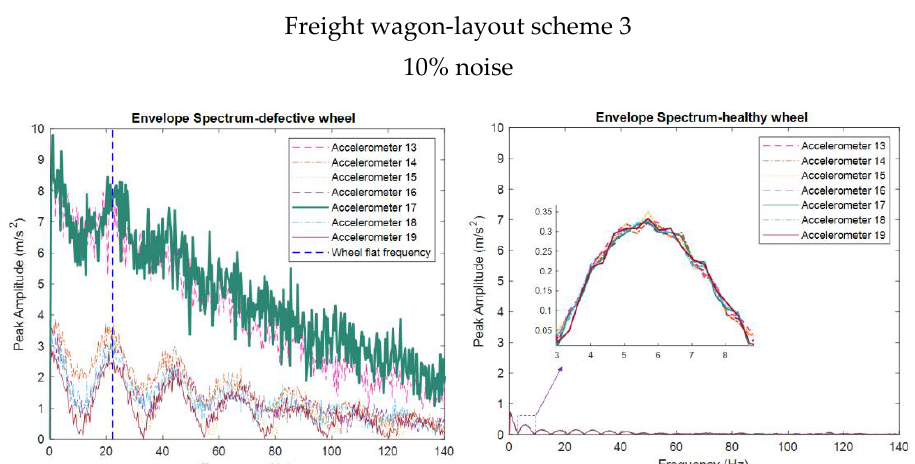
2 ) Figure 16. Optimization of the sensor layout. The installation along an equivalent wheel perimeter length (2 (cid:2024)(cid:1870) (cid:3050) = 2.7 m ) is useful for monitoring the entire perimeter of the wheel. Figure 16 shows that from an economic point of view, two accelerometers are needed to distinguish a defective from a healthy wheel. Regarding the position of the sensors, it is better to install them so that, with every rotation of the wheel, each sensor monitors half the length of the wheel perimeter. The length of the wheel perimeter is 2 (cid:2024)(cid:1870) (cid:3050) = 2.7 m . Therefore, each time the defective wheel contacts the surface of the rail, the same impact will occur again 2.7 m later. For example, if the flat impact location occurs before accelerometer 19 (see Figure 5), it means that in the previous rotation of the wheel, the accelerometer 14, which is located 3.0 m away, could also detect the impact at a close distance. For this reason, it is recommended that accelerometers should be installed in such a way that for each wheel rotation, one accel- erometer could monitor half of the wheel circumference (2.7/2 = 1.35 m), which is the dis- tance between three sleepers, to guarantee that at least one accelerometer is close to the location of the flat impact. In the actual installation, it is not necessary to install 12 sensors along the rail to identify the profiles of the wheels during the operation of the vehicle. 7. Sensitivity of the Layout Schemes to the Severity of the Flat As previously stated, when the envelope spectrum analysis is carried out using ac- celeration signals, the amplitudes of the envelope spectrum obtained in a scenario with P ea k A m p li t ude ( m / s